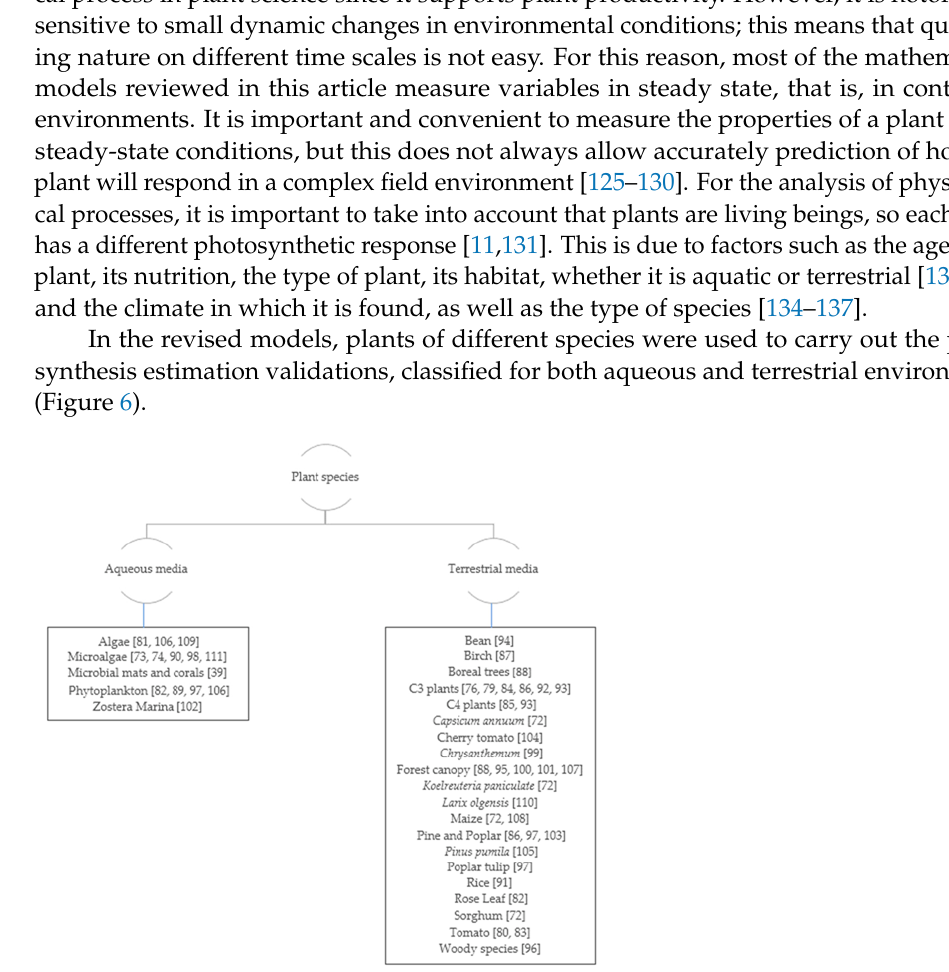
Figure 6. Plant species used in the mathematical models classified by aqueous and terrestrial environments. Refs.